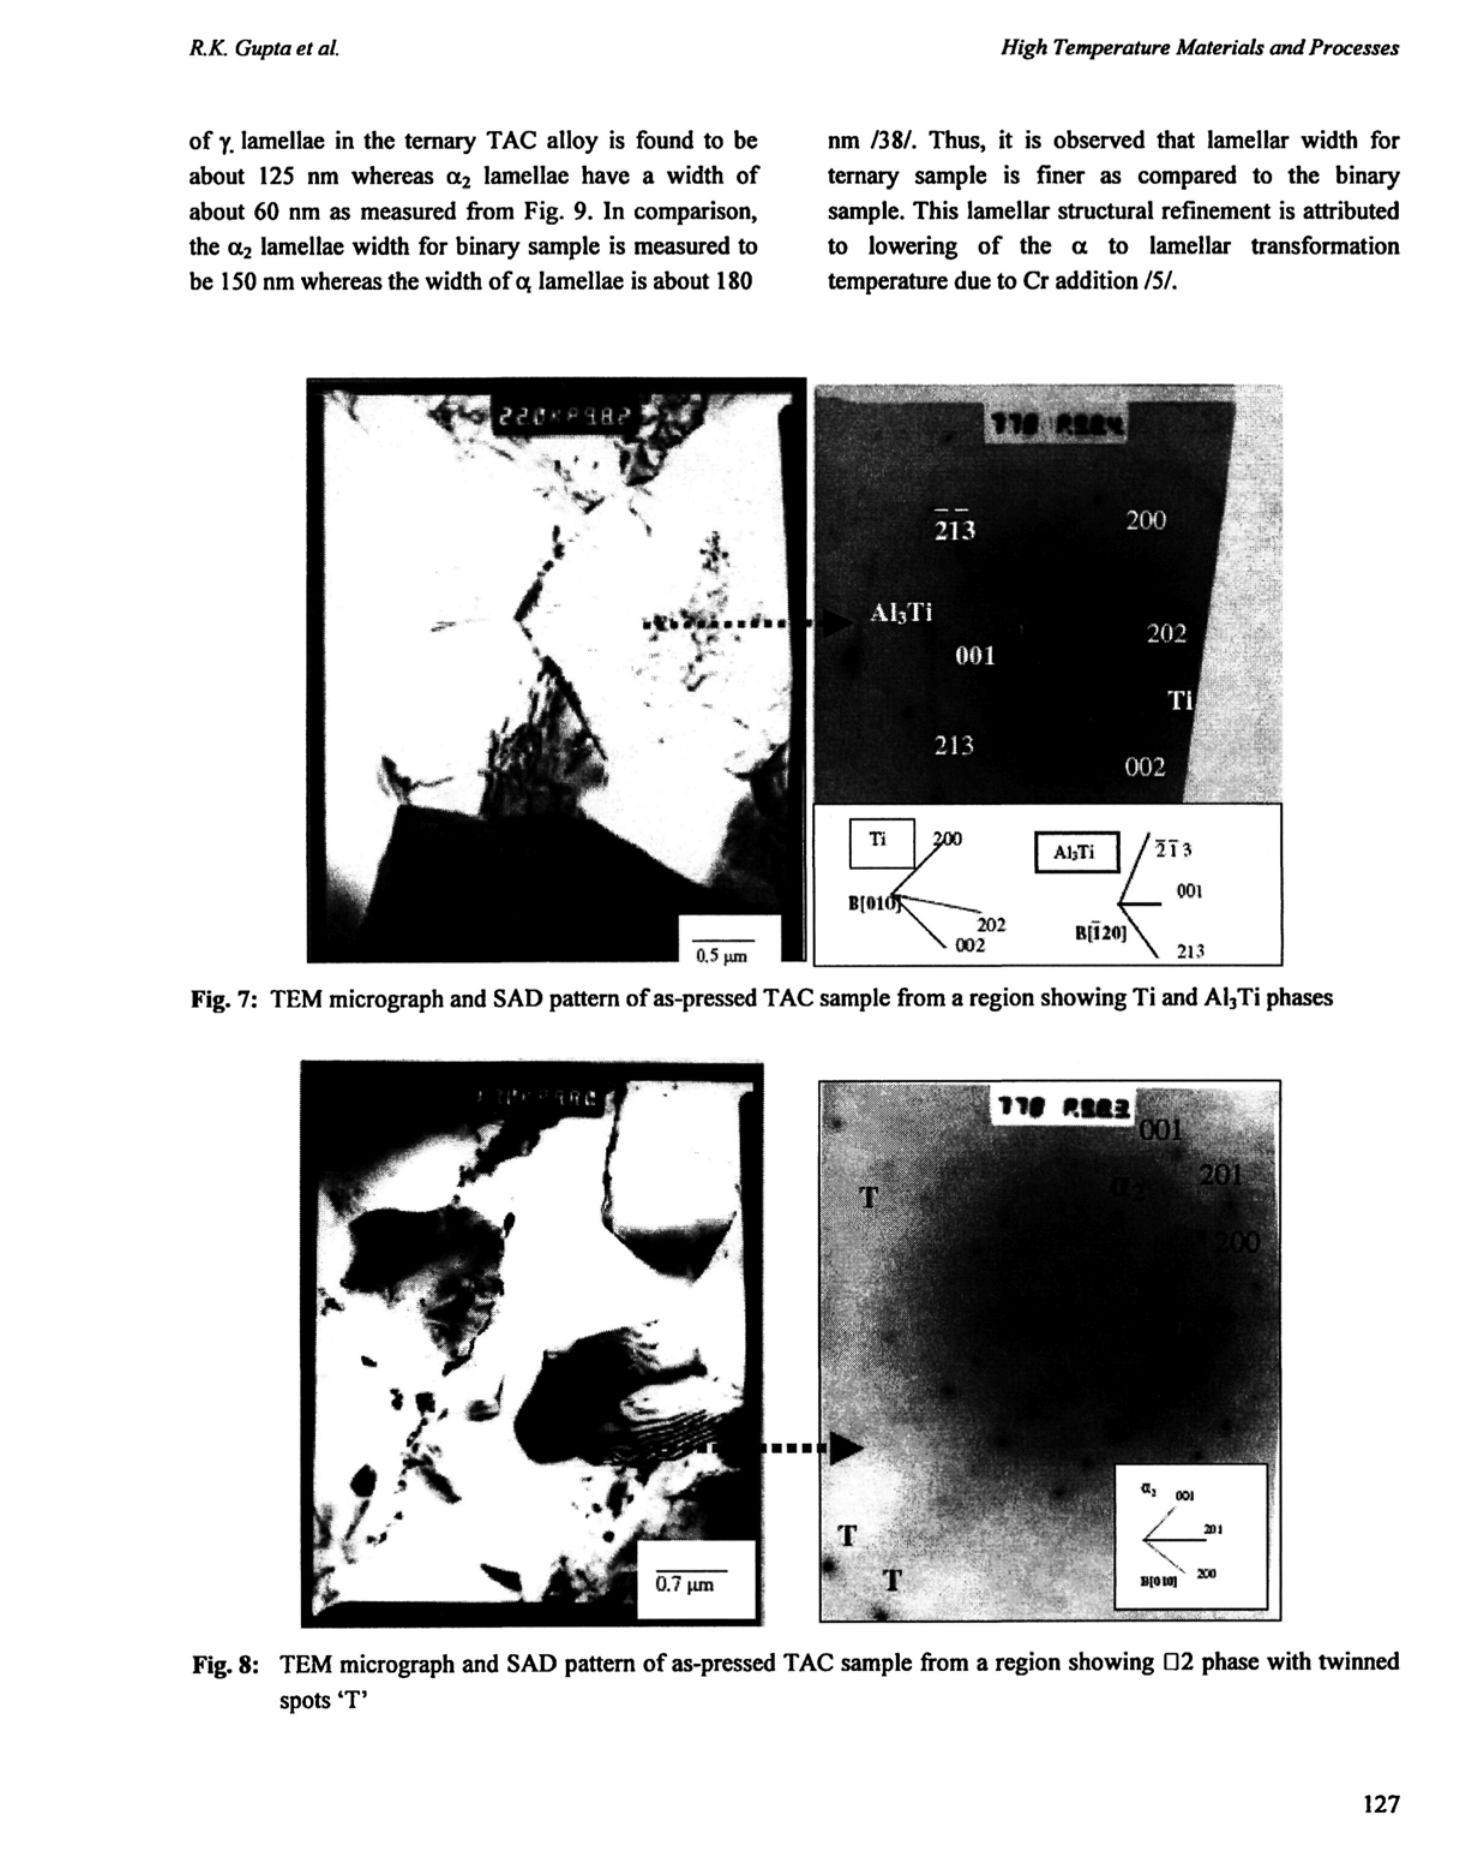
Fig. 8: TEM micrograph and SAD pattern of as-pressed TAC sample from a region showing D2 phase with twinned spots 'T'